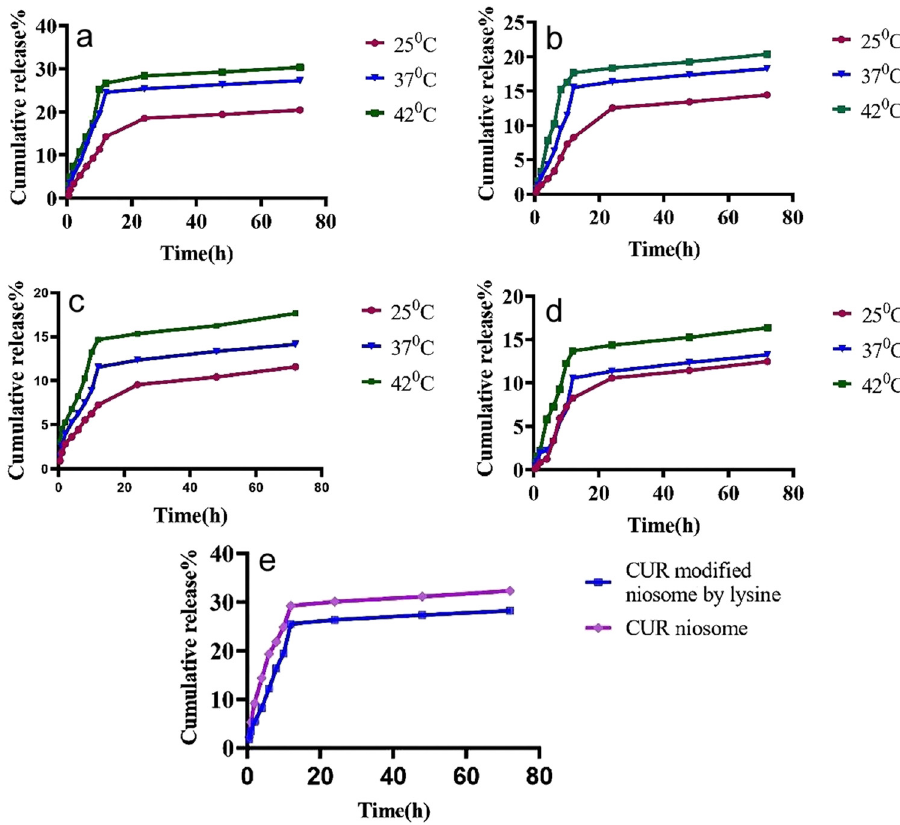
Figure 5: ( a and b ) In vitro release of the modi fi ed niosomal NPs in PBS at pH 7.4 and 5.5; ( c and d ) in vitro release of the modi fi ed niosomal NPs in plasma at pH 7.4 and 5.5; ( e ) the release rate of DOTAB - mediated niosomal NPs and lysine - mediated niosomal NPs in PBS at pH 7.4 for 72